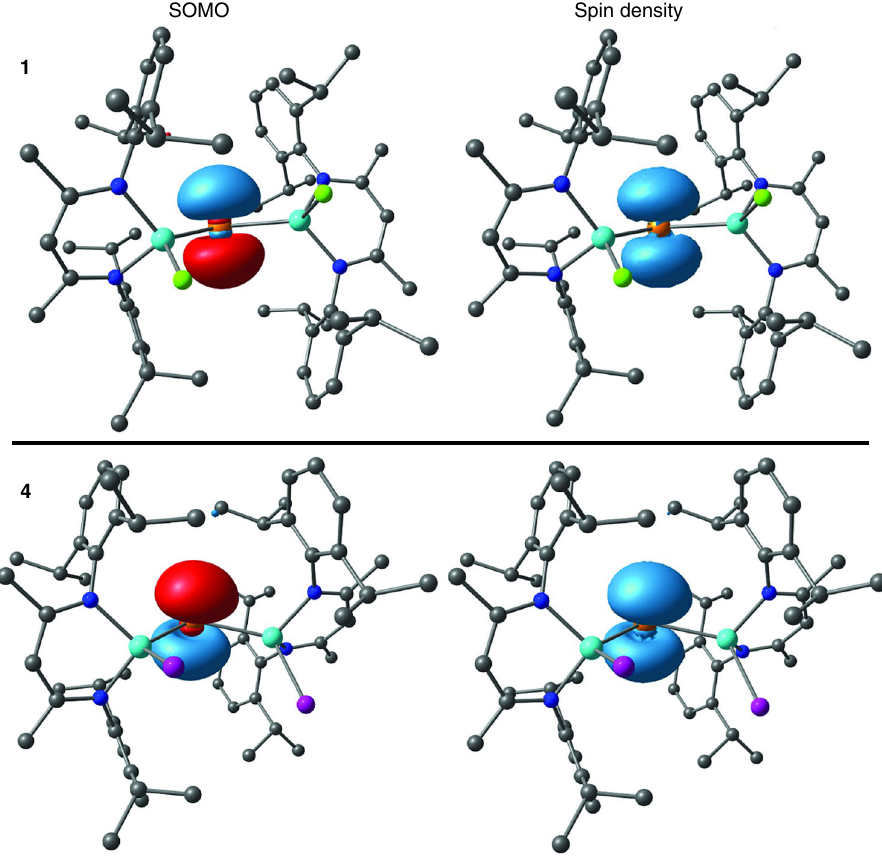
Fig. 5 Geometry optimized structure of 1 ′ and 4 ′ . The SOMO orbitals and spin densities exhibit the p-orbital character of the radical ’ s unpaired